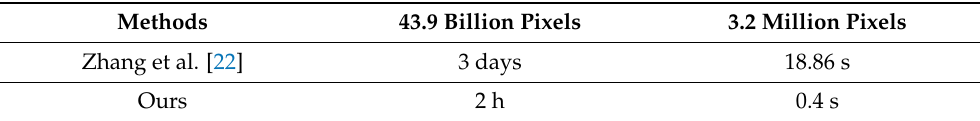
Table 1. Calculation time for color categories and balance weights. The values show that our method is faster to compute.